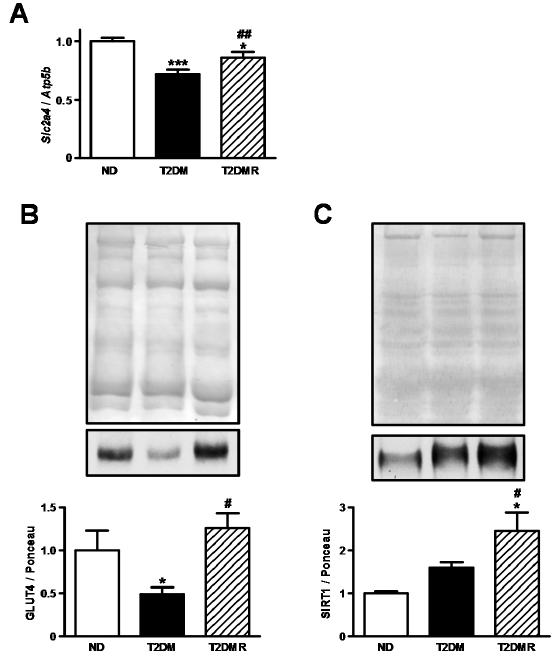
Figure 2. Resveratrol restored Slc2a4 mRNA and GLUT4 protein expression in skeletal of T2DM mice. Slc2a4 mRNA ( A ); GLUT4 protein ( B ), and nuclear SIRT1 protein ( C ) were analysed in gastrocnemius